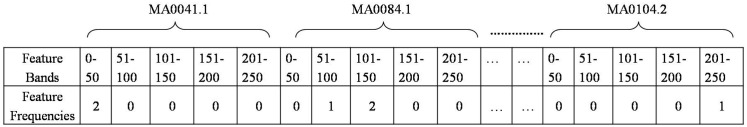
Feature vector of promoter 1.